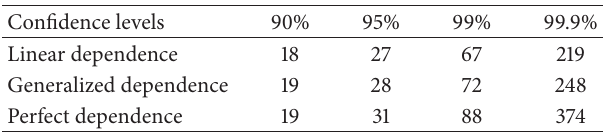
Table 6: VaR of operational risk under different dependence assumptions (CNY